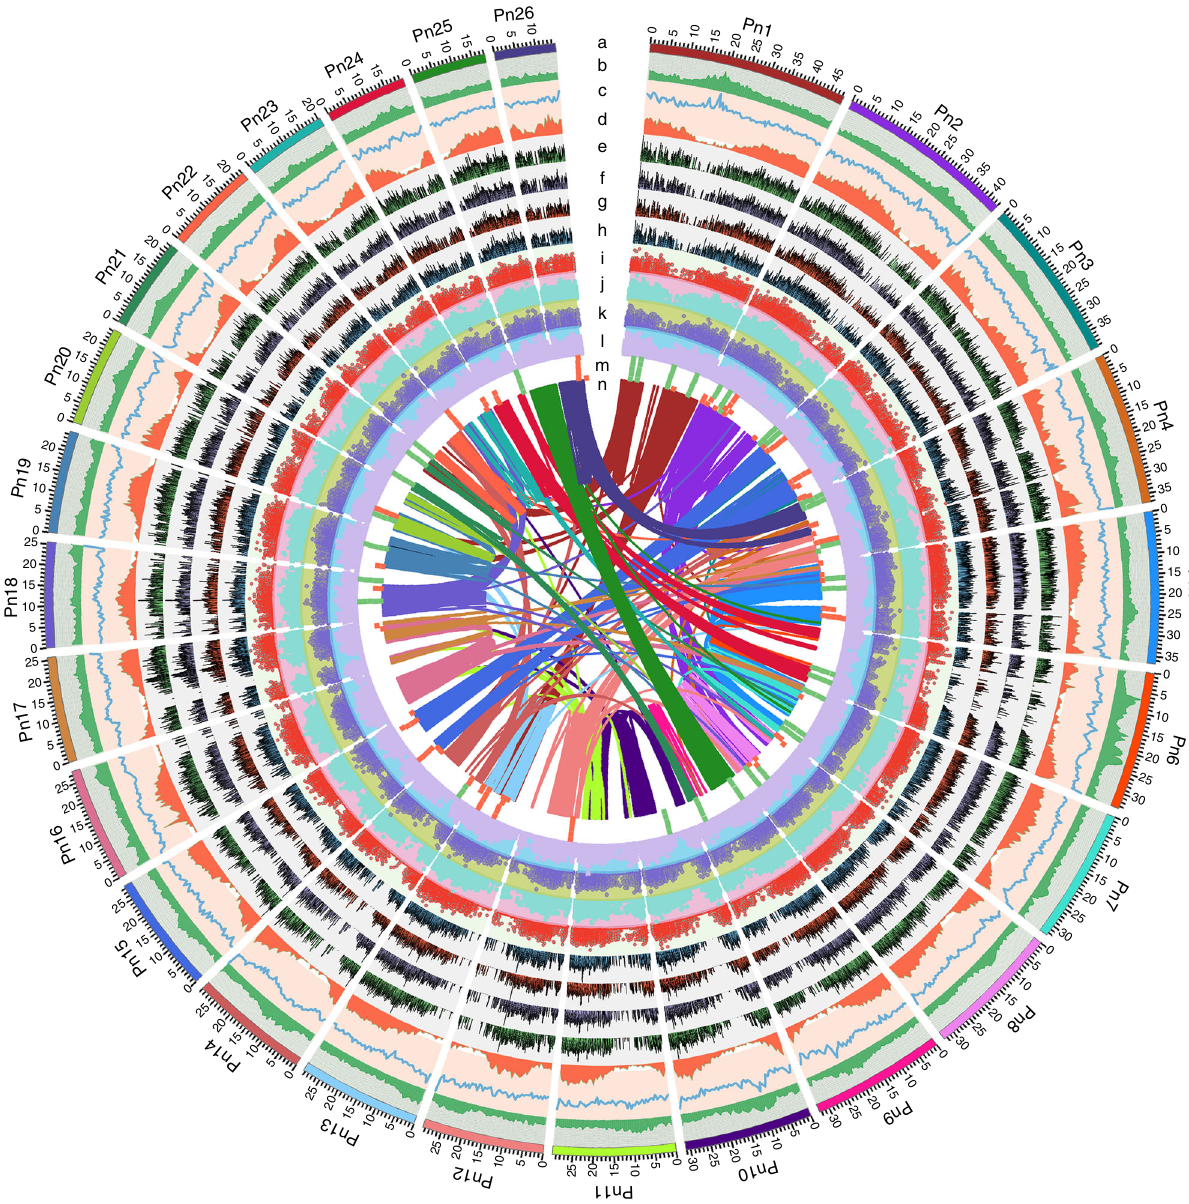
Fig. 1 Black pepper genomic landscape of diversity and expression data. a Circular representation of the pseudomolecules. b – d The distribution of the GC density, repeat density and gene density, respectively, with densities calculated in 500 Kb windows. e – l Expression of berry-speci fi c genes (from outside to inside tracks: 2 MAP, 4 MAP, 6 MAP, 8 MAP, root, stem, leaf and fl ower). m Locations of genes mapped to secondary metabolism (green square) and alkaloid metabolism (red square) pathways. n Syntenic blocks. The band width is proportional to syntenic block size. Source data are provided as a Source Data fi